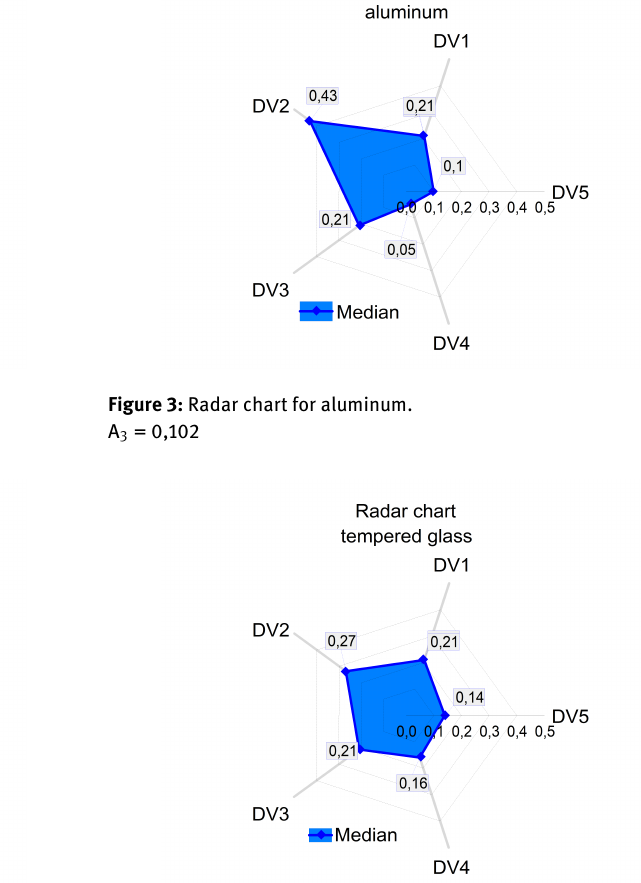
wall”, 3-aluminium panel, 4-tampered glass screen, 5- timber panel.